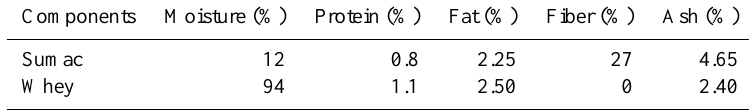
Table 2. Chemical composition of the sumac and dried whey (% dry matter).